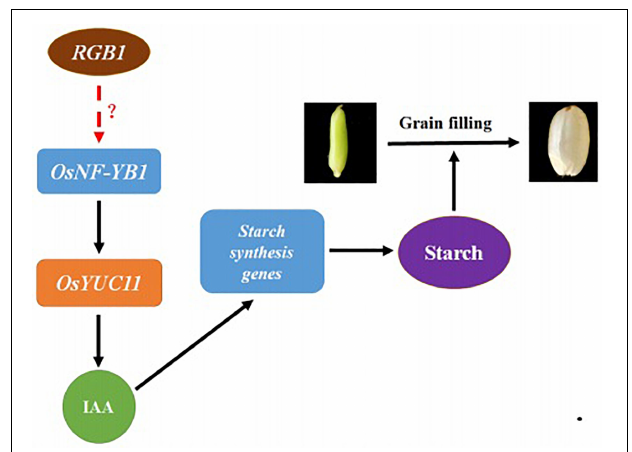
FIGURE 6 | A working model on RGB1 regulation on grain filling. RGB1 may positively regulate expression of transcription factor OsNF-YB1 through unknown mechanism(s), which activates the OsYUC11 transcription by interacting with its promoter, and leads to an increase in auxin level. The increased auxin then stimulates the expression of sucrose metabolism and starch biosynthesis-related genes in endosperm cells, as a consequence, the biosynthesis of starch and grain